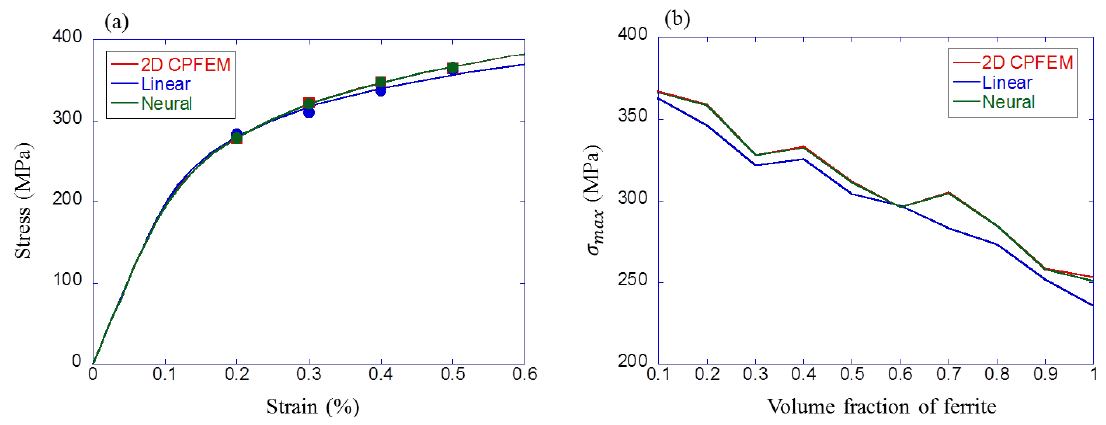
Figure 14. Comparison results between simulation and machine learning. ( a ) Only strain amplitude